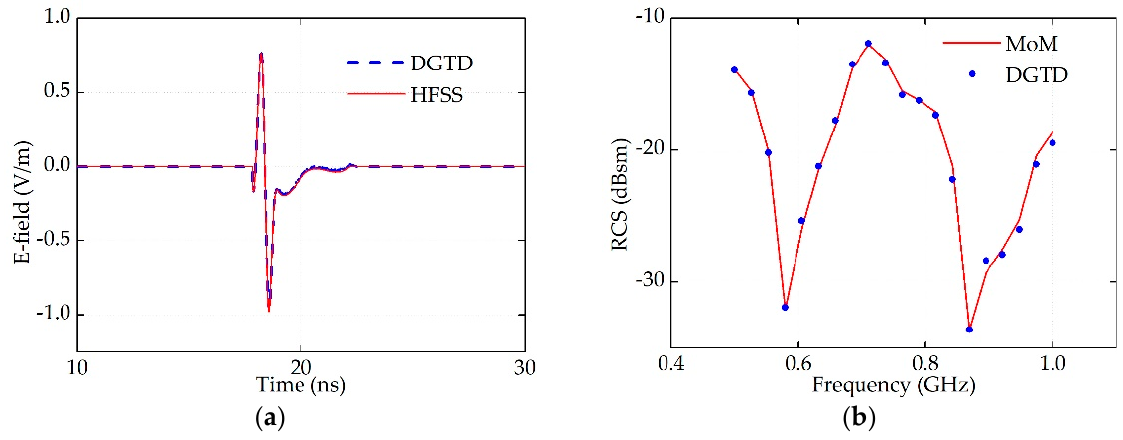
Figure 8. The RCS of a multi-scale object above a PEC plate computed at ( a ) 0.5 GHz and ( b ) 1 GHz from the solutions of the DGTD method and MoM.